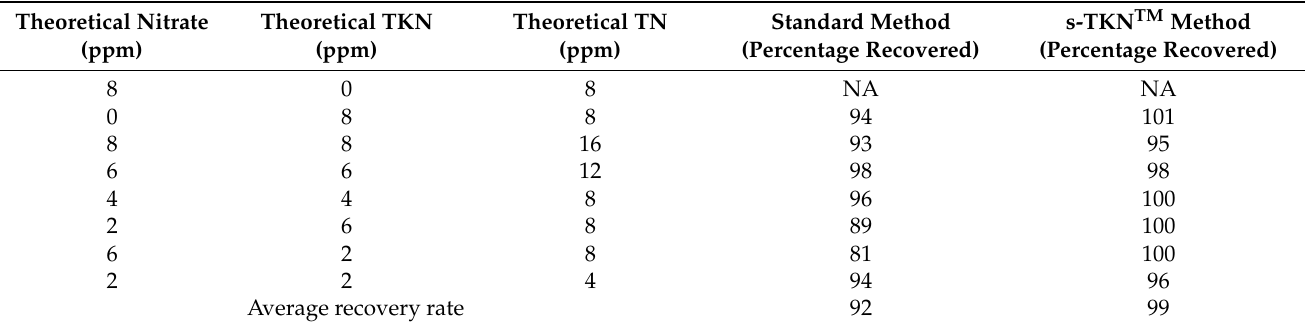
Table 4. Recovery rates of TKN from mixed standard - glycine–PTSA and nitrate for the standard and s-TKN TM methods.